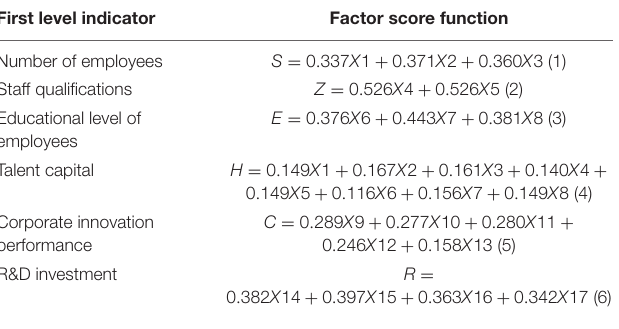
TABLE 3 | Factor score function in the first-level indicators.